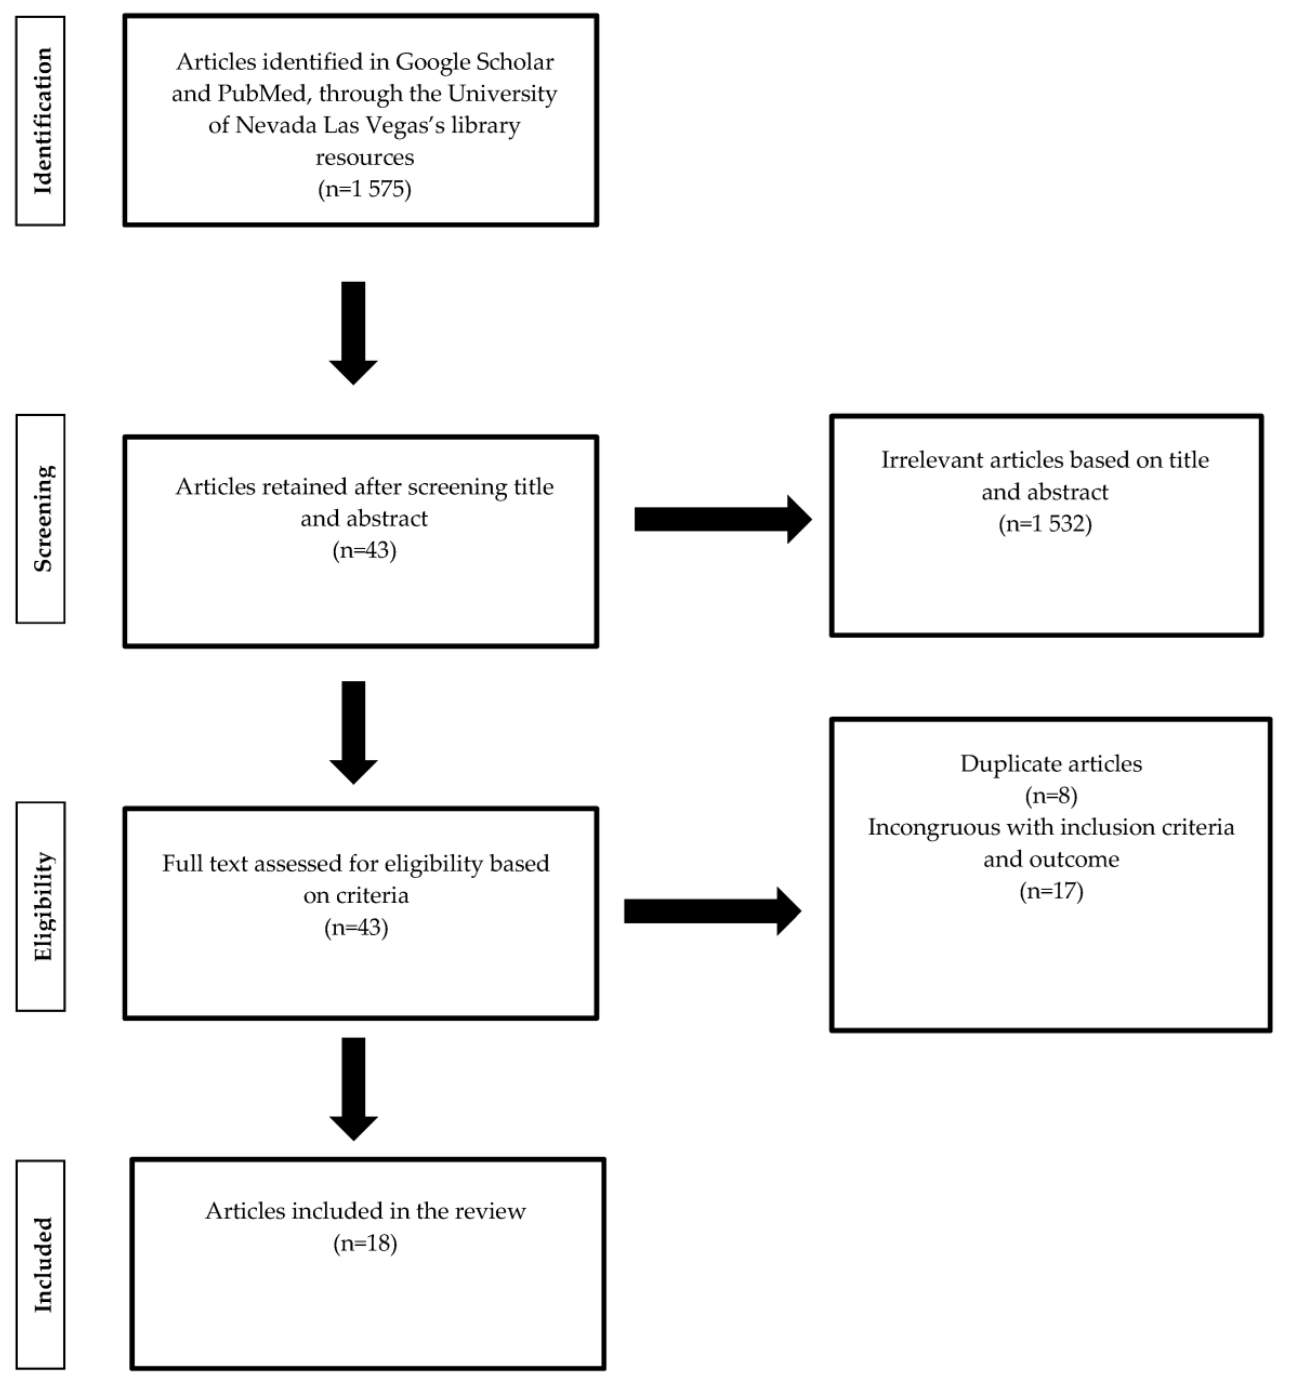
Figure 1. Literature review search process.